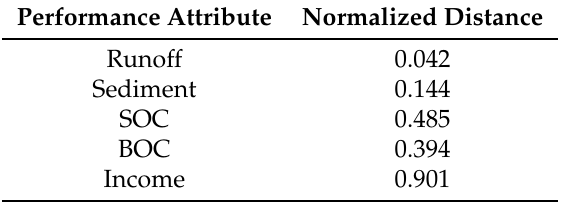
Table 12. Normalized distances of the solution produced by BIOLP for weight runof f = 0.6 and all other weights fixed to 0.1 ( λ was set to